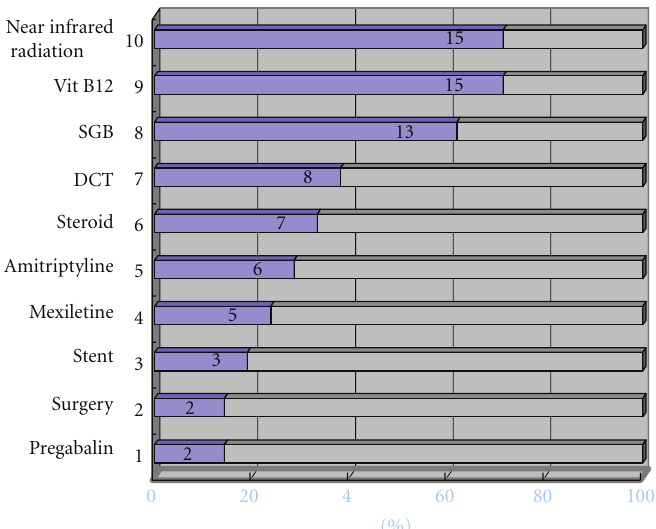
Figure 12: Methods of treatments after nerve injury used at Tokyo Dental College Suidoubashi Hospital (2008.4-2009.3) SGB: stellate ganglion block; DCT: drug-challenge test